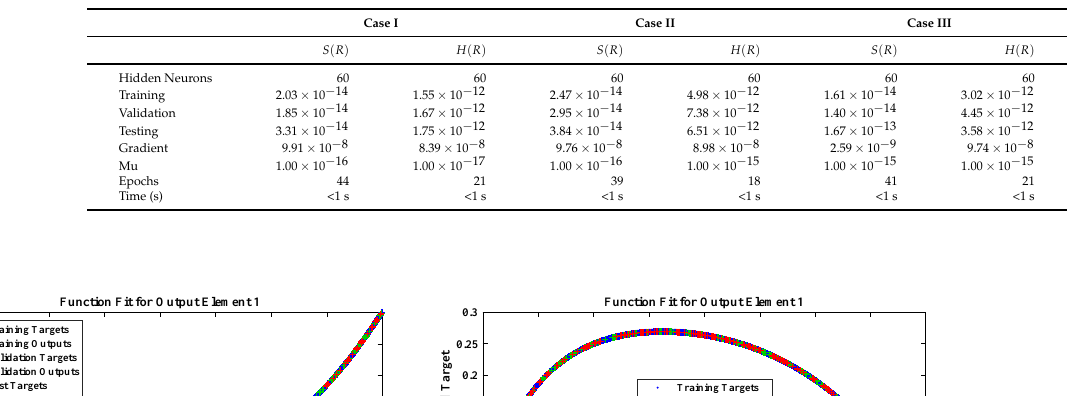
Table 3. Statistical analysis of performance measures including MSE, Gradient, mu, number of iterations and time taken by the system for obtaining the results of Scenario II.